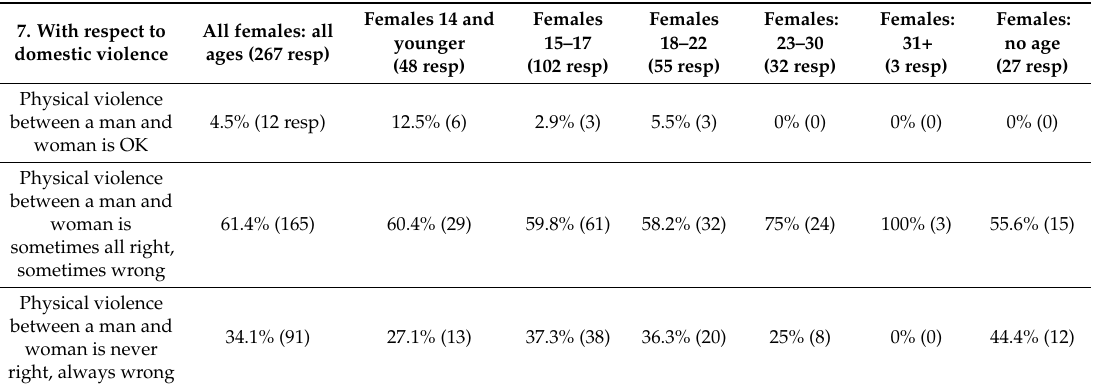
Table 12. Attitudes towards Domestic Violence—All